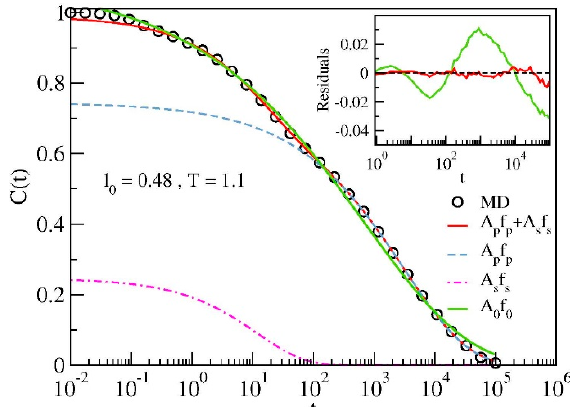
Figure 3. Illustrative example of the best-fit results via the double-relaxation function Equation (5). The best-fit with the single-relaxation function A 0 f 0 with f 0 in the form of Equation (6) is also shown. Inset: residuals of the best-fit with the double- and single- relaxation functions.